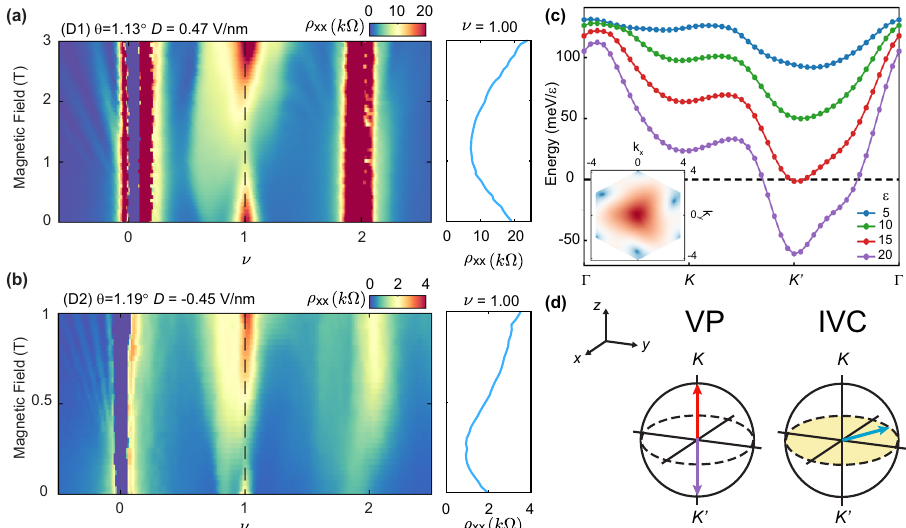
Fig. 2 Magnetic fi eld dependence and ground state ordering of the ν = 1 state. a , b ρ xx as a function of doping and B at T = 0.1 K for D > 0 in device D1 ( a ) and at T = 0.05 K for D < 0 in device D2 ( b ). Cuts of ρ xx ( B ) are shown at ν = 1 in the panels to the right of each map, at positions indicated by the black dashed lines in the main panels. Note that ν is the fast sweeping axis in these measurements, and as a consequence, the measured ρ xx is substantially smaller than its true value for the insulating states; Supplementary Fig. 8a shows a more faithful measurement of ρ xx at ν = 1 in device D1. c Calculated energy of valley magnon formation in tMBG with θ = 1.16 ∘ at selected values of ϵ . The inset shows the pro fi le of the intervalley exciton, F ( k ), as a function of crystal momentum in the fi rst Brillouin zone, with the magnitude represented by a log color scale. F ( k ) ≠ F ( − k ), indicating that the Q-IVC state breaks TRS. k a a x , y have units 1/ M , where M is the moiré lattice constant. d Bloch sphere representation of the VP and IVC states. VP states point towards the north (south) pole for K (K') polarization, as indicated by the red (purple) arrows. IVC states (blue arrow) point along any direction in the x – y plane